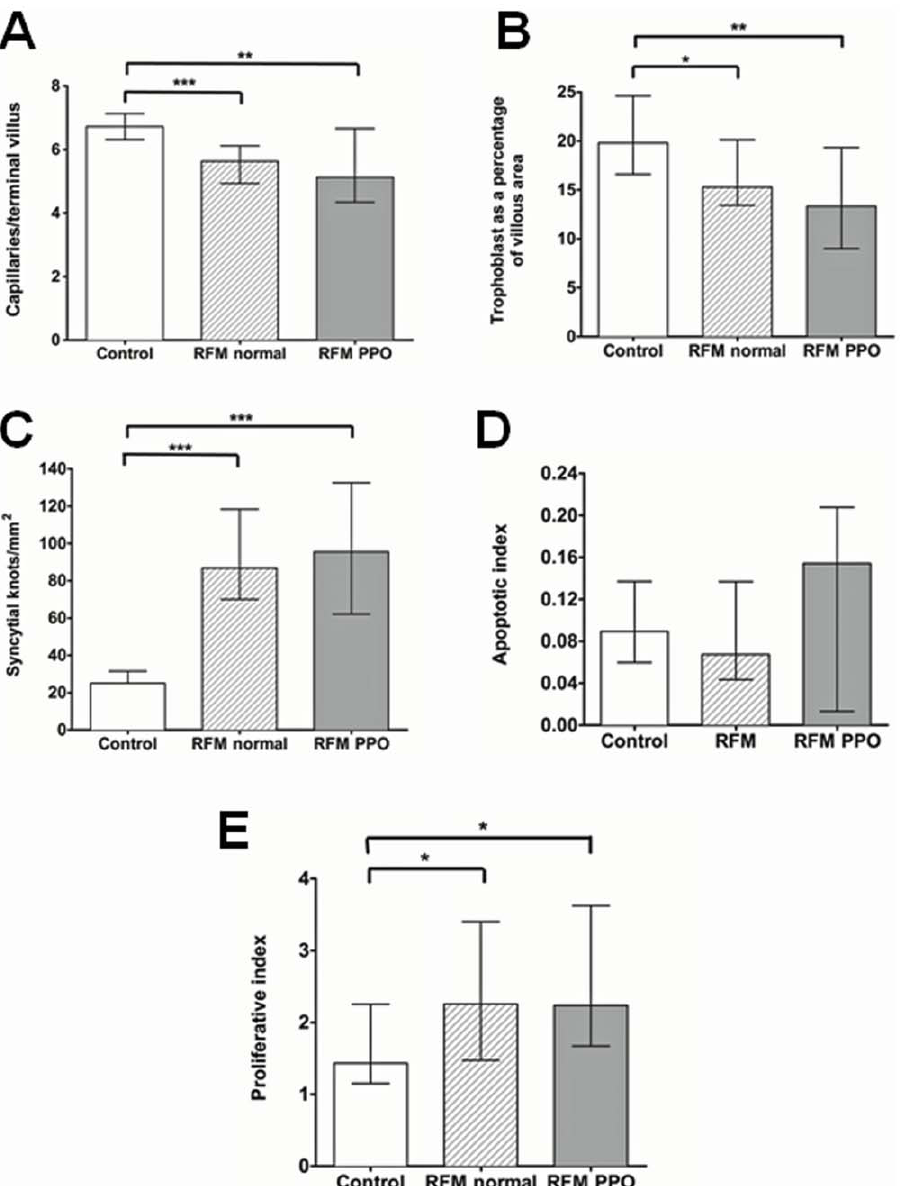
Figure 3. Microscopic structure of RFM placentas split by those with normal and poor pregnancy outcomes (PPO). demonstrating that the same pattern in abnormal villous structure is present in all women with RFM with respect to: A) Villous vascularity B) Trophoblast area C) Density of syncytial knots D) Apoptosis E) Proliferative Index. (* p , 0.05, **p , 0.01, ***p , 0.001, Kruskal-Wallis Test).